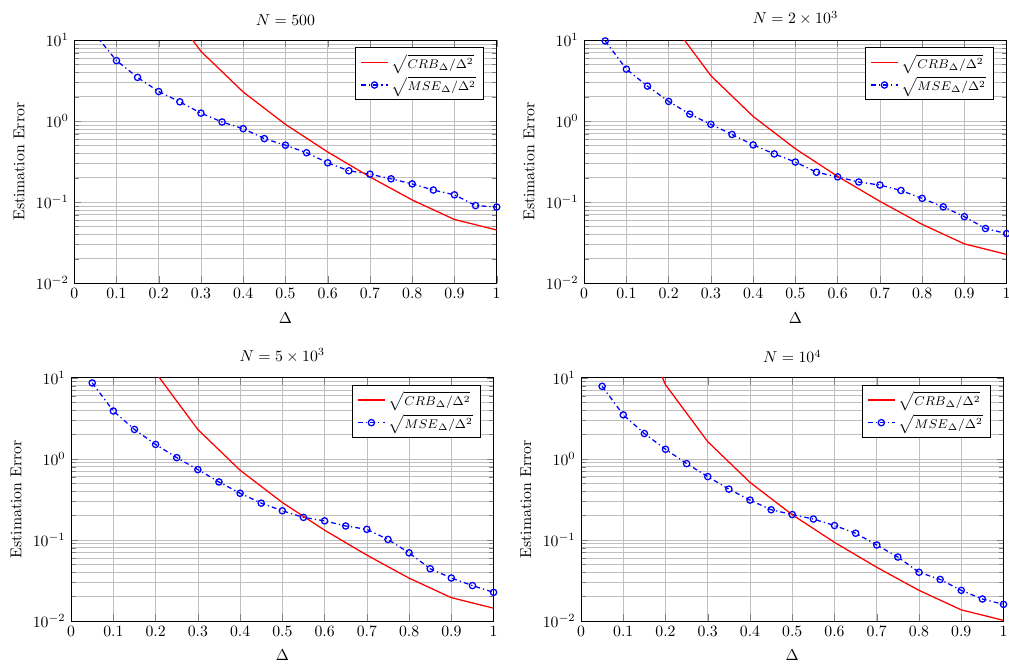
Figure 8. Square root of CRB ∆ and MSE ∆ normalized by ∆ for the estimation of ∆ using Equation (16) for K = 3 and different number of observations N